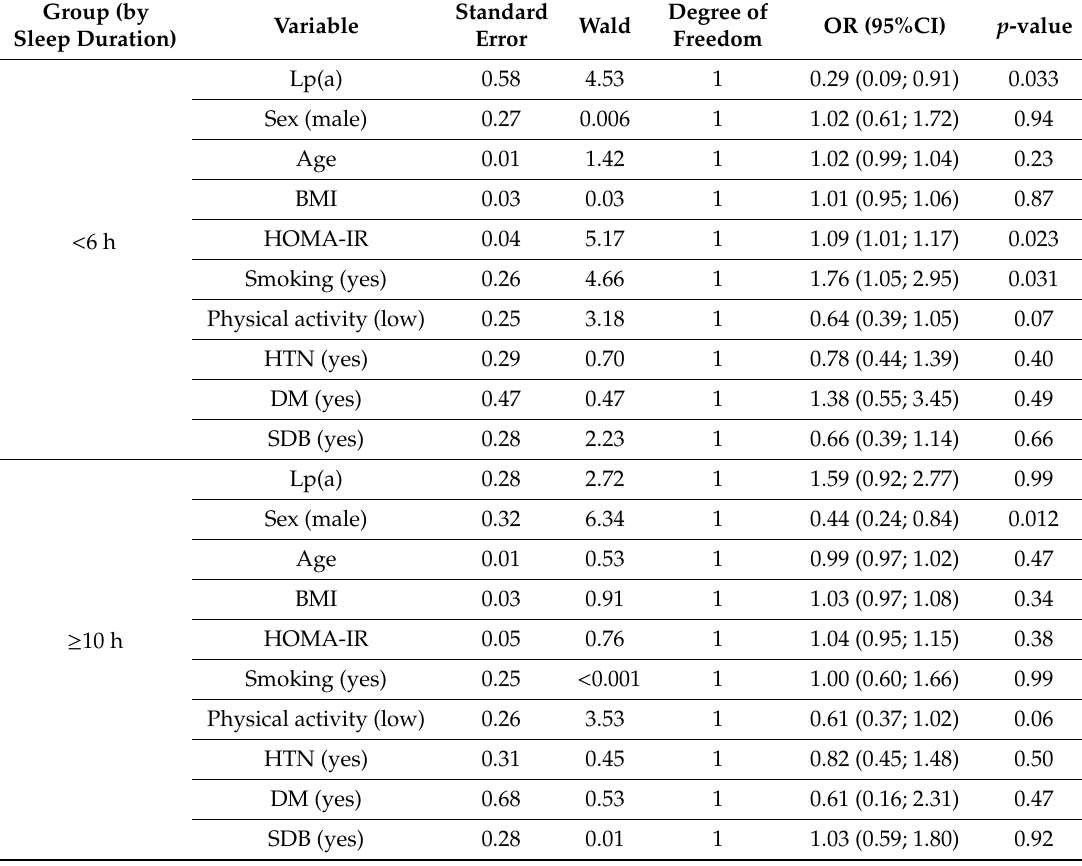
Table 4. The association between sleep duration and other factors (the multinomial logistic